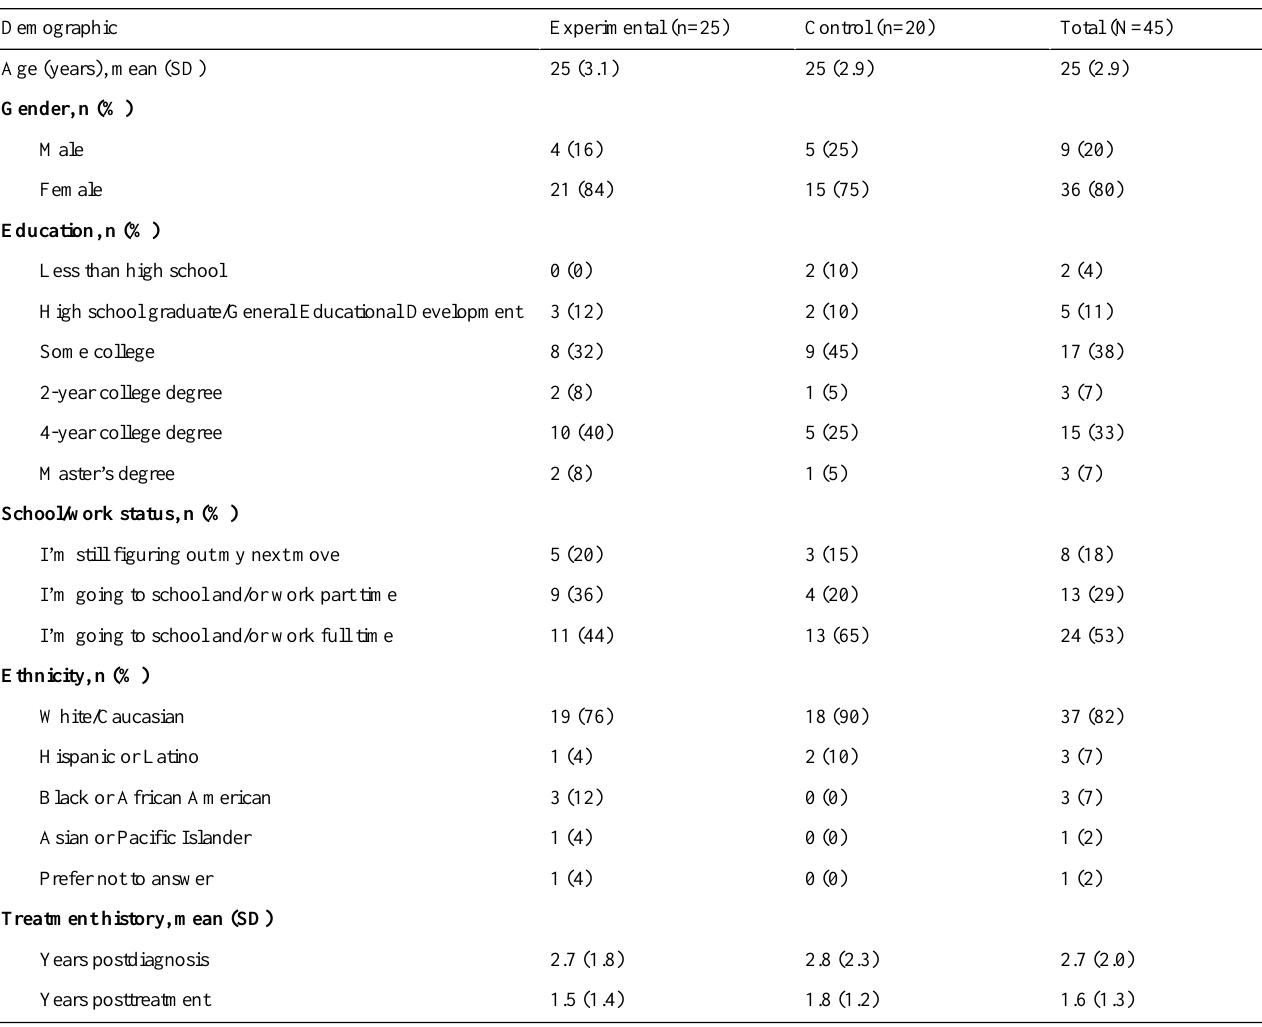
Table 1. Demographic data of